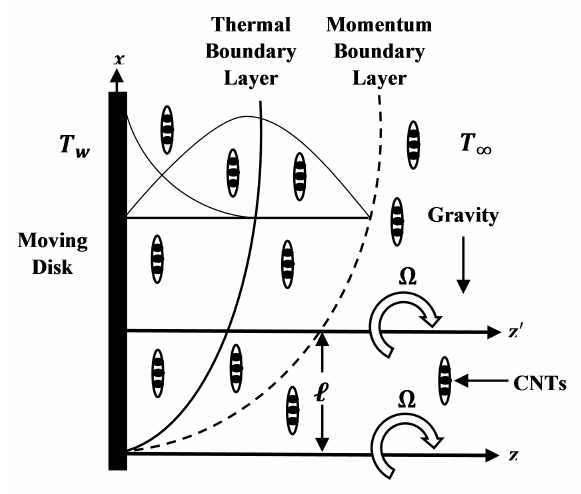
Fig. 1. The governing equations on non-coaxial rotation of Newtonian nanofluid flow is given as [26].